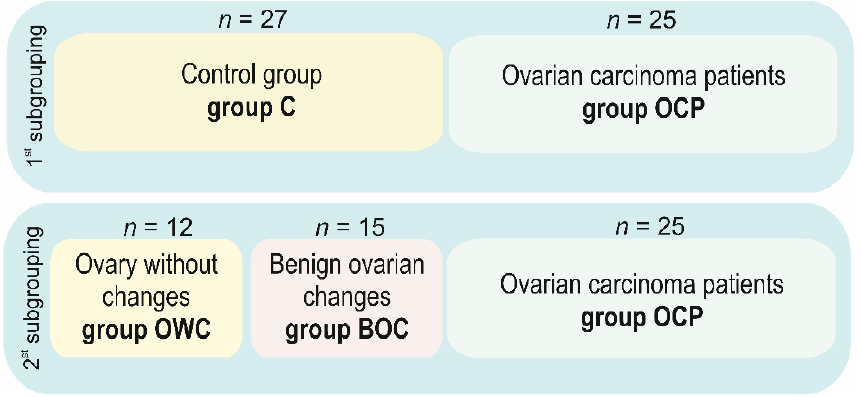
Figure 7. Study material. Diagram showing the number of tissue samples, allocated to different ex- amined